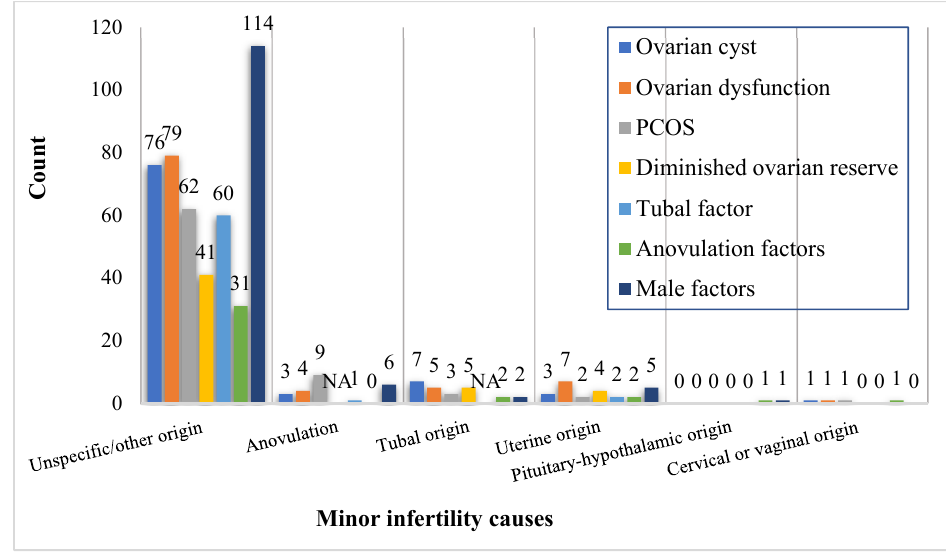
Figure 3. Distribution of fertility clinic attendees by the documented causes of infertility.